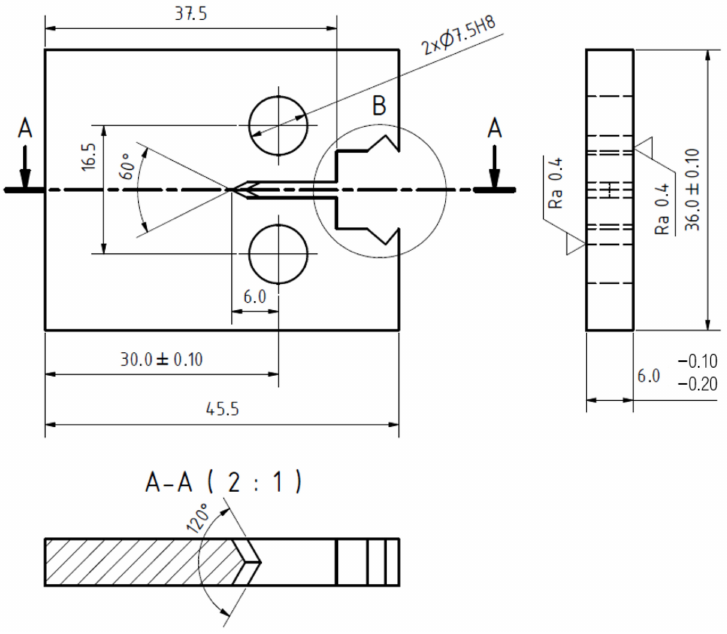
Figure 1. Geometry of the CT specimens used for the crack growth rate measurements. Measurement of the crack growth rates in terms of the da/dN vs. ∆ K curves was carried out using the testing machine with a linear motor Instron e10000 (Instron, Norwood, MA, USA) and the resonant testing machine Zwick Vibrophore 25 (Zwick Roell GmbH, Ulm, Germany). In the case of Instron e10000 the capacity and maximal amplitude was 10